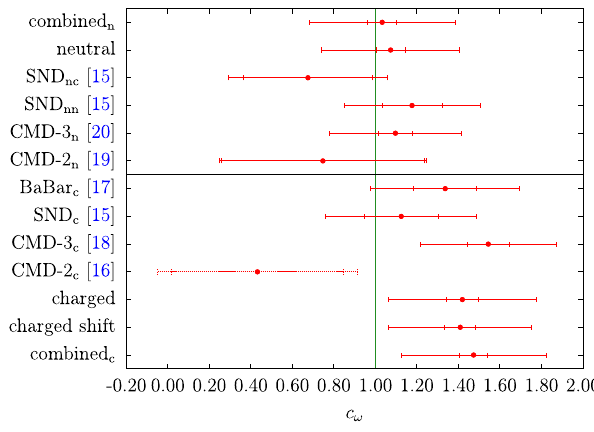
Fig. 2 Results of the individual and the combined neutral and charged data sets for c φ (left) and c ω (right), with the neutral/charged-channel- residues in the upper/lower panel. The green line denotes the SU(3)- prediction. “combined n ” and “combined c ” refer to the scenarios in which the φ resonance parameters and all couplings are fit simulta- neously, “neutral” and “charged” to the ones in which only the timelike